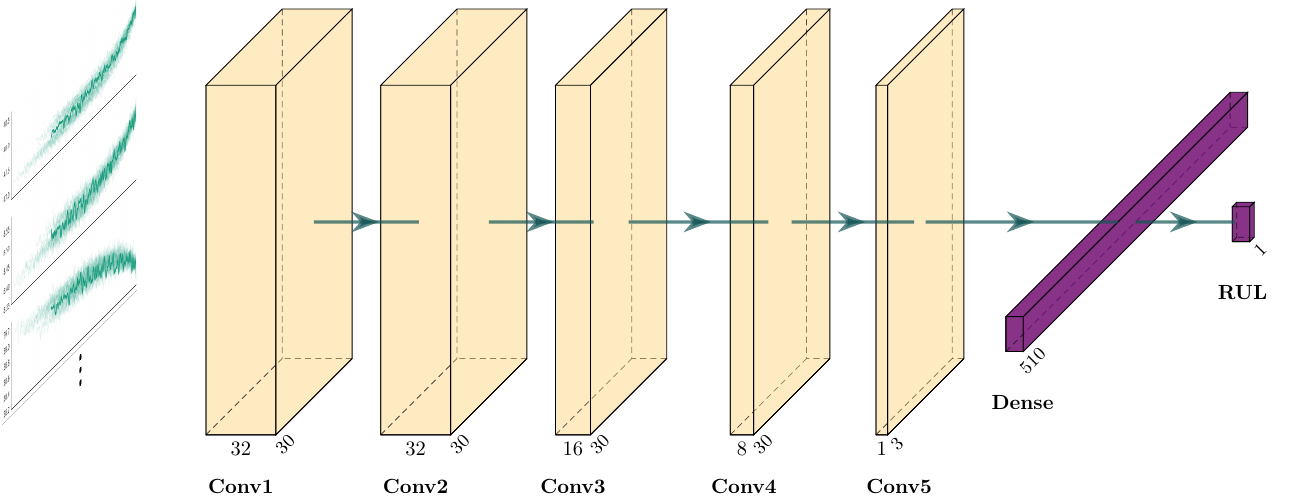
Figure 9. The proposed architecture for RUL